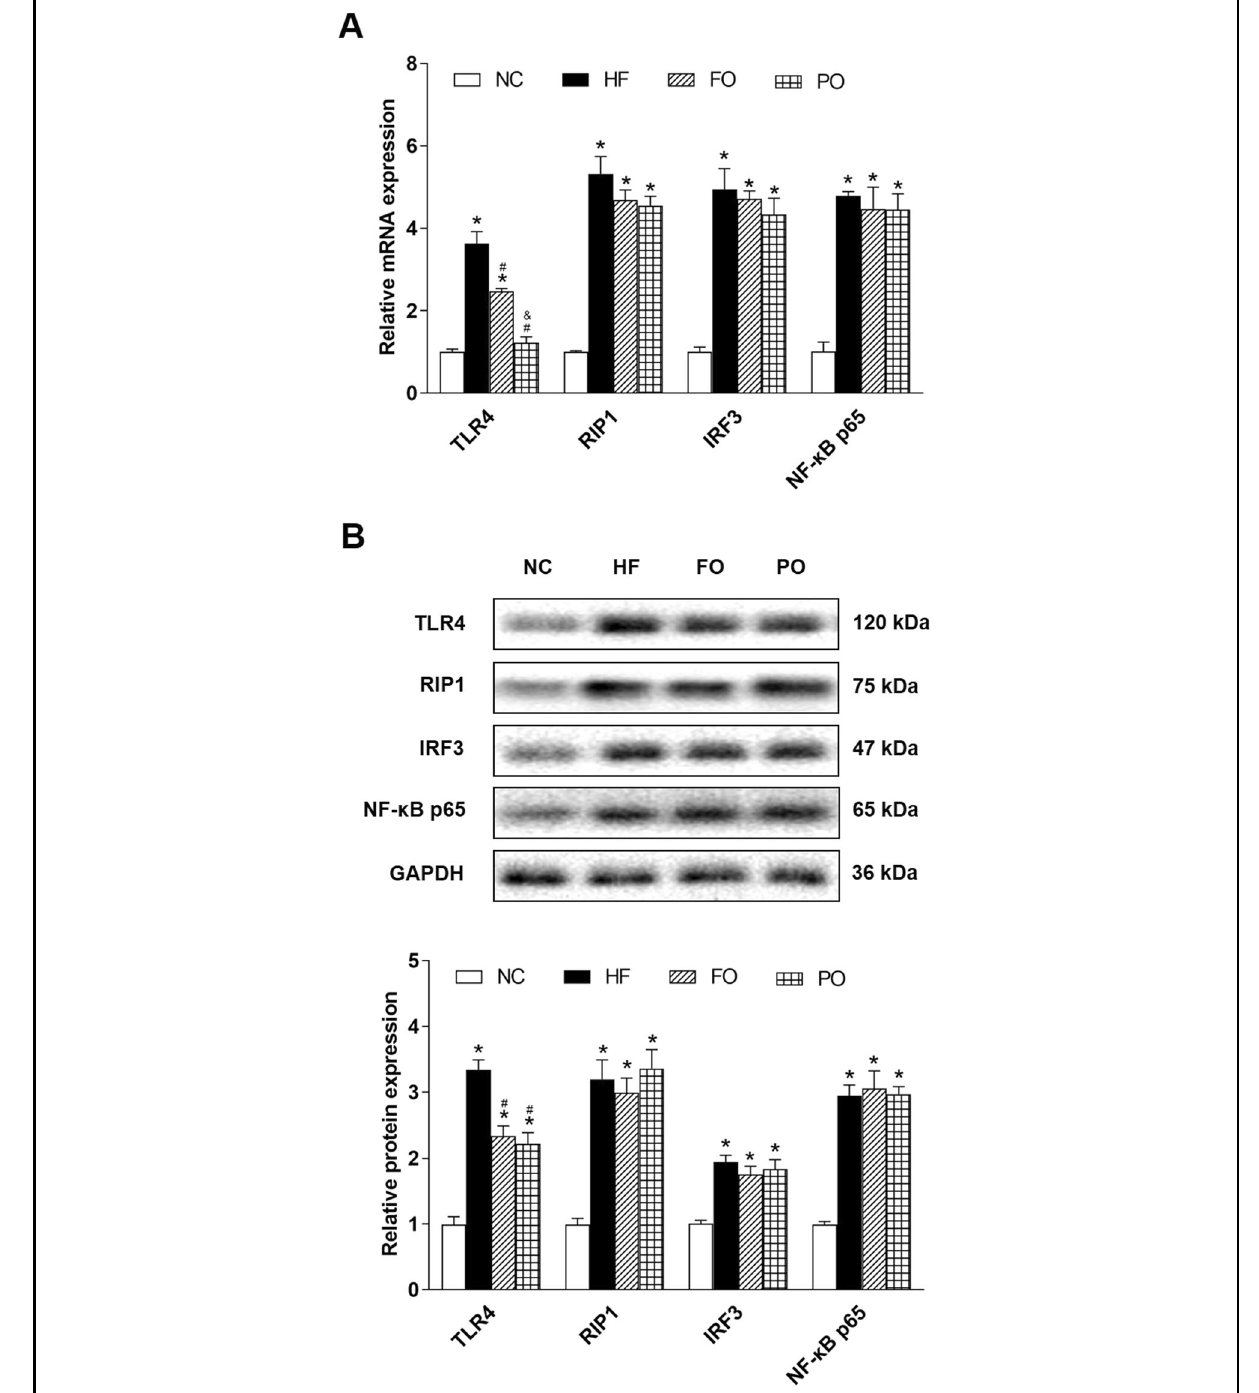
Fig. 4 Effects of FO and PO on MyD88-independent pathway of TLR4 signaling in MyD88 − / − mice. A Relative mRNA expression; B representative western blots images (upper) and relative protein expression (bottom). NC normal chow, HF high fat, FO fi sh oil, PO perilla oil, TLR4 toll-like receptor 4, RIP1 receptor-interacting protein-1, IRF3 interferon regulate factor 3, NF- κ B p65 nuclear factor-kappa B p65, GAPDH glyceraldehyde-3-phosphate dehydrogenase. Data are presented as the mean ± standard deviation. * P < 0.05, compared with NC; # P < 0.05, compared with HF; & P < 0.05, compared with